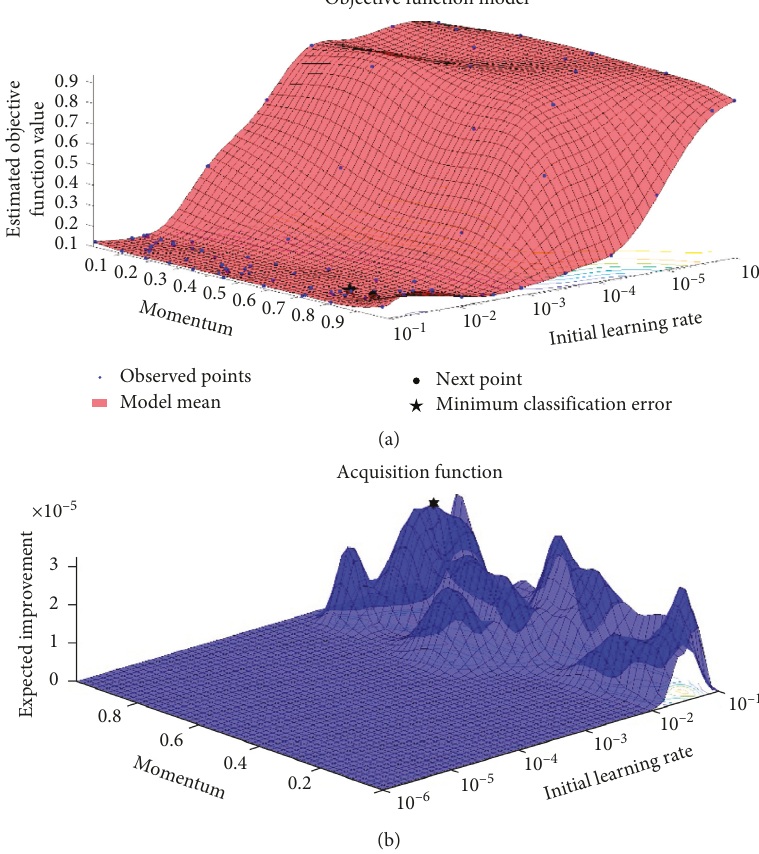
Figure 5: (a) The observation function model. (b) Acquisition function for two parameters of the SGDM. The starred points are the calculated optimal values at the 69 th iteration for λ and η .